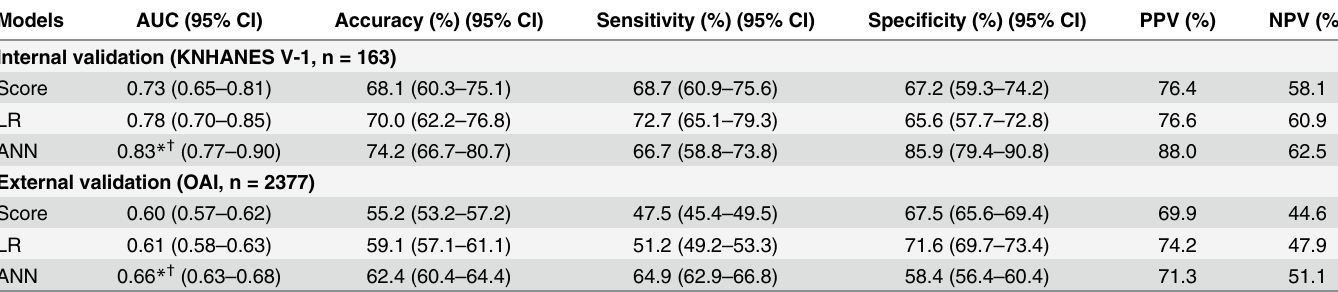
Table 4. Performance of prediction models for radiographic osteoarthritis among the participants with knee pain. Models